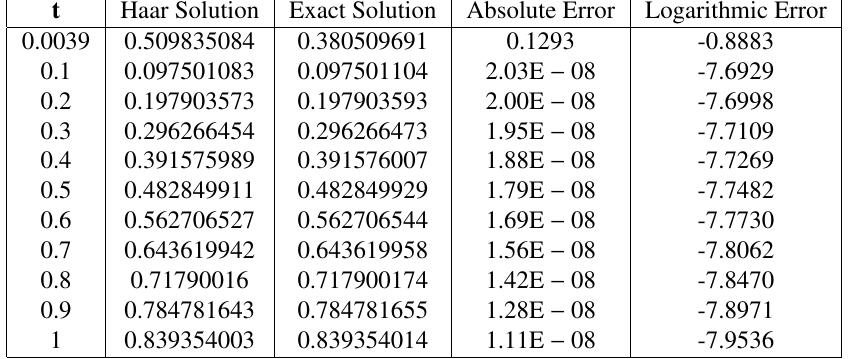
Table 3. Numerical results, exact solutions and errors for Example 2 for J =